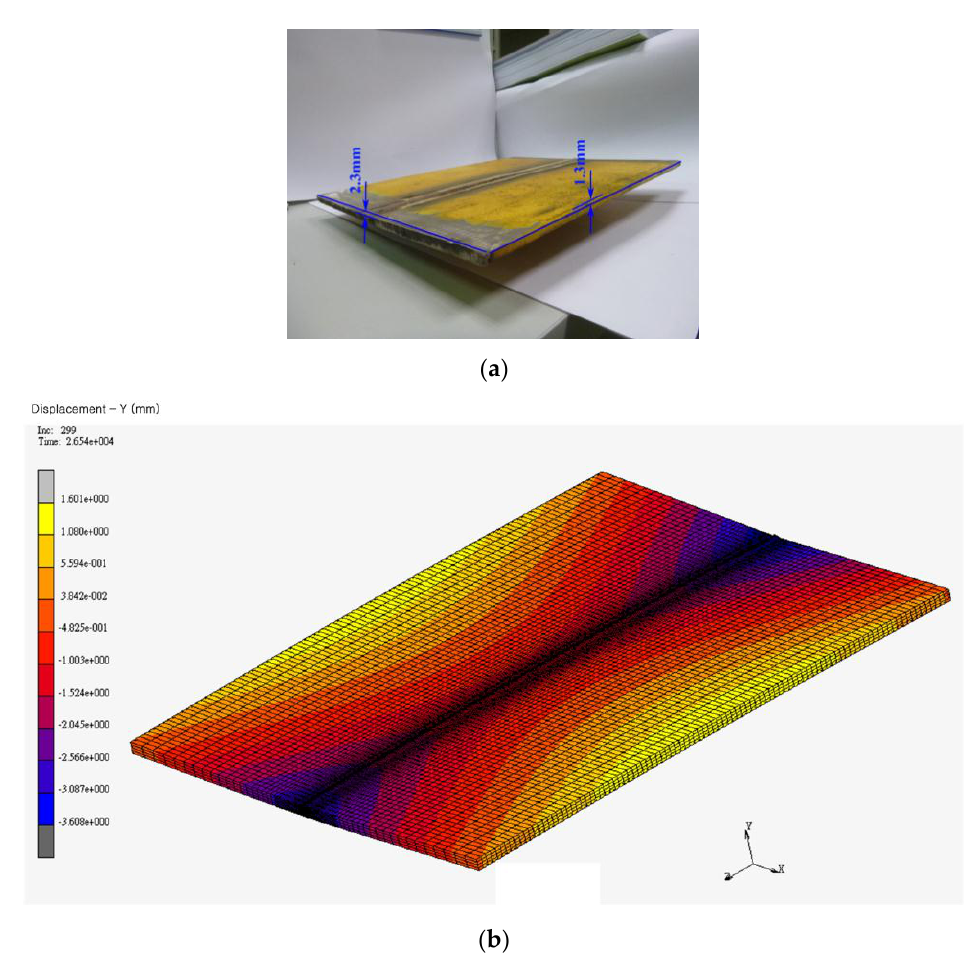
Figure 8 . Deformation without jigs: ( a ) actual situation; ( b ) simulation analysis.